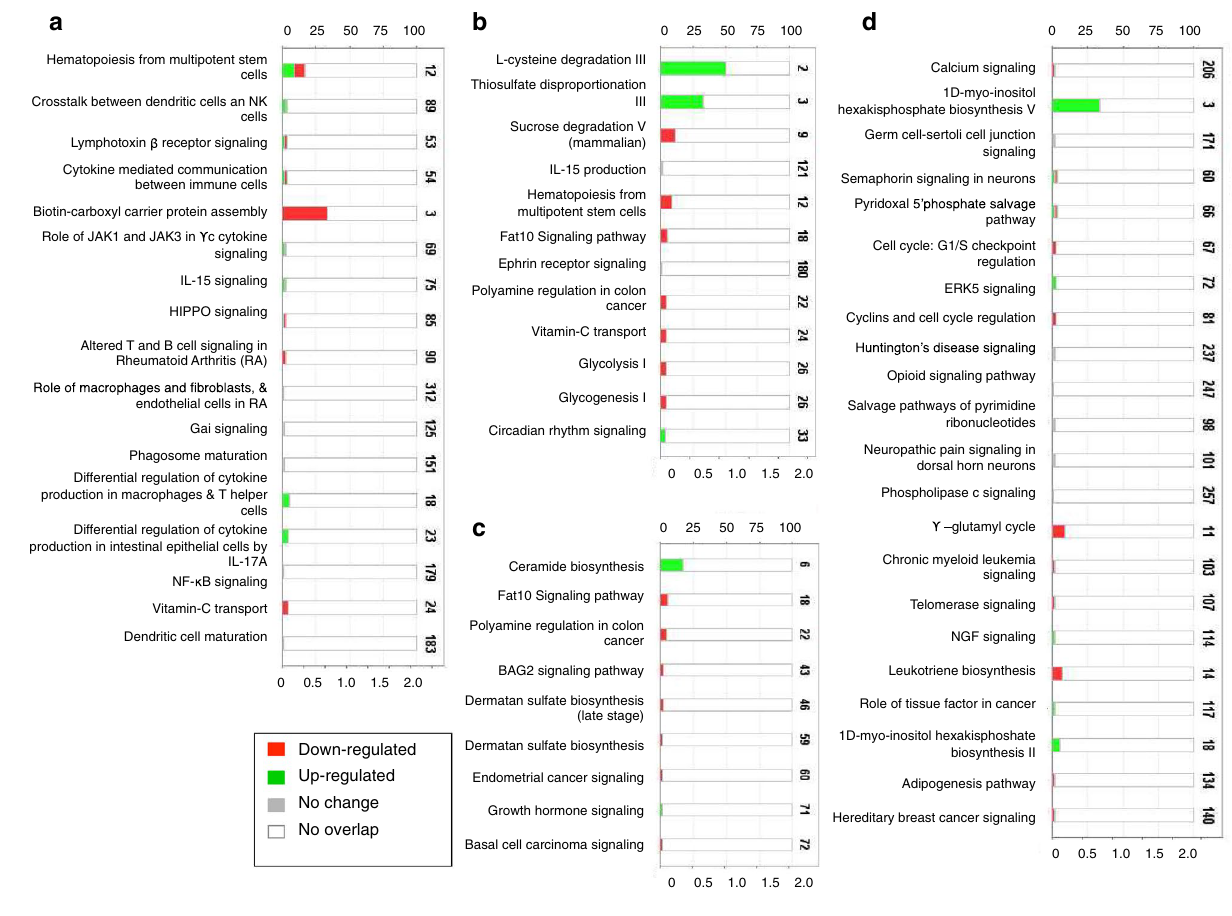
Figure 2. Canonical pathways identified as significantly enriched using IPA in ( a ) High versus low heat stressed samples, ( b ) high versus low control heat stressed samples, ( c ) control versus heat stressed high samples, ( d ) control versus heat stressed low samples. The bottom axes of graphs shows the − log(p-value), and the upper axes show the percentage of genes in each pathway. The total number of genes in each pathway is shown at the end of each bar. This figure was generated through the use of IPA (QIAGEN Inc., https:// www. qiage nbioi nform atics. com/ produ cts/ ingen uityp athway- analy